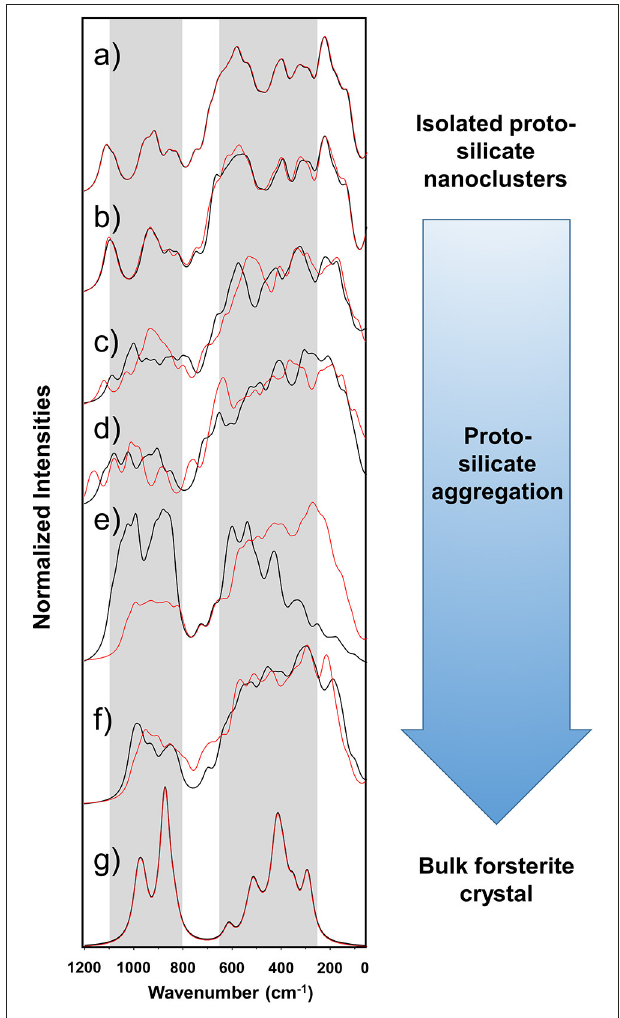
FIGURE 4 | Calculated IR spectra of the silicate aggregates. The calculated IR spectra of the Mg 6 Si 3 O 12 nanocluster and the crystalline forsterite bulk are also included. Gray shading indicates the bands from observational measurements, centered at ca. 1,000 and 550 cm − 1 , the width of which being the corresponding full width at half maximum (FWHM) ranges [from Henning (2010) ]. Black spectra are those for the systems shown in Figure 1 (Sil-1_1 is omitted because it is equal to Sil-0). Red spectra are those for the systems shown in Figure 2 (Sil-2_1 is omitted because it is equal to Sil-0). The spectra are superimposed to show that irrespective of the aggregation process route the final dense structures are very similar observationally. (a) Sil-0, (b) Sil-1_2 and Sil-2_2, (c) Sil-1_3 and Sil-2_3, (d) Sil-1_4 and Sil-2_4, (e) Sil-1_5 and Sil-2_5, (f) Sil-1_6 and Sil-2_6, and (g) forsterite crystalline Mg 2 SiO 4 bulk. Intensities are normalized to 100 with respect to the most intense band and accordingly they are in arbitrary